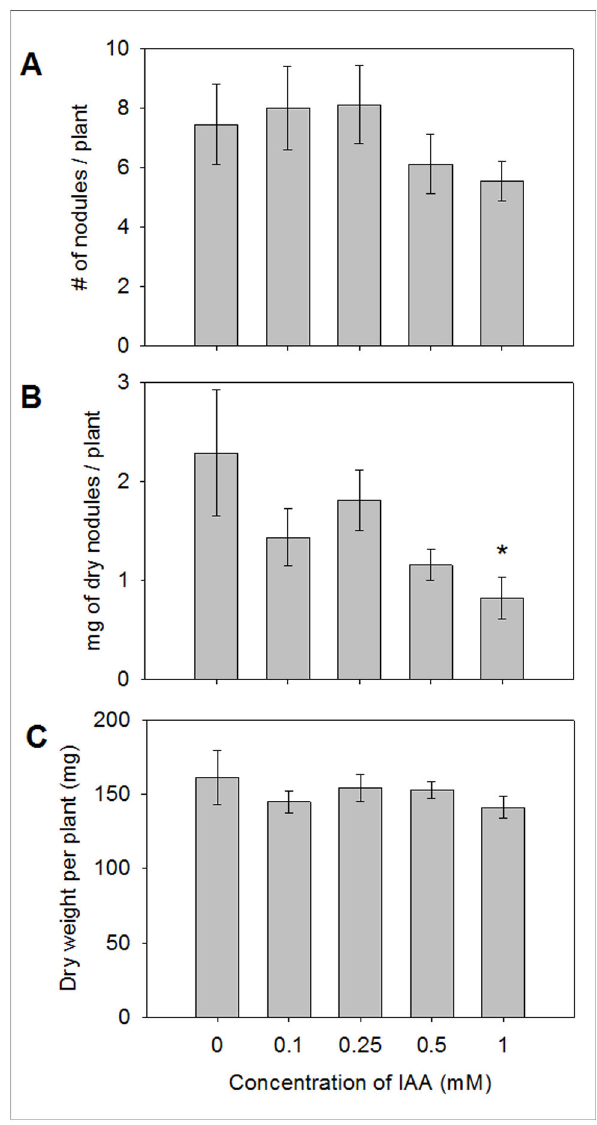
Figure 7. Effect of IAA pretreatment on soybean nodulation by B. japonicum . Panel A, B, and C present the number of nodules, nodule dry weight, and plant dry weight, respectively. For measuring dry weights of nodules and plants, samples were dried at 70 °C for 3 days. An asterisk (*) indicates that the value is statistically different ( P = 0.044) from the control value based on Student’s t-test. Values are the mean ± the standard error of the mean for 9